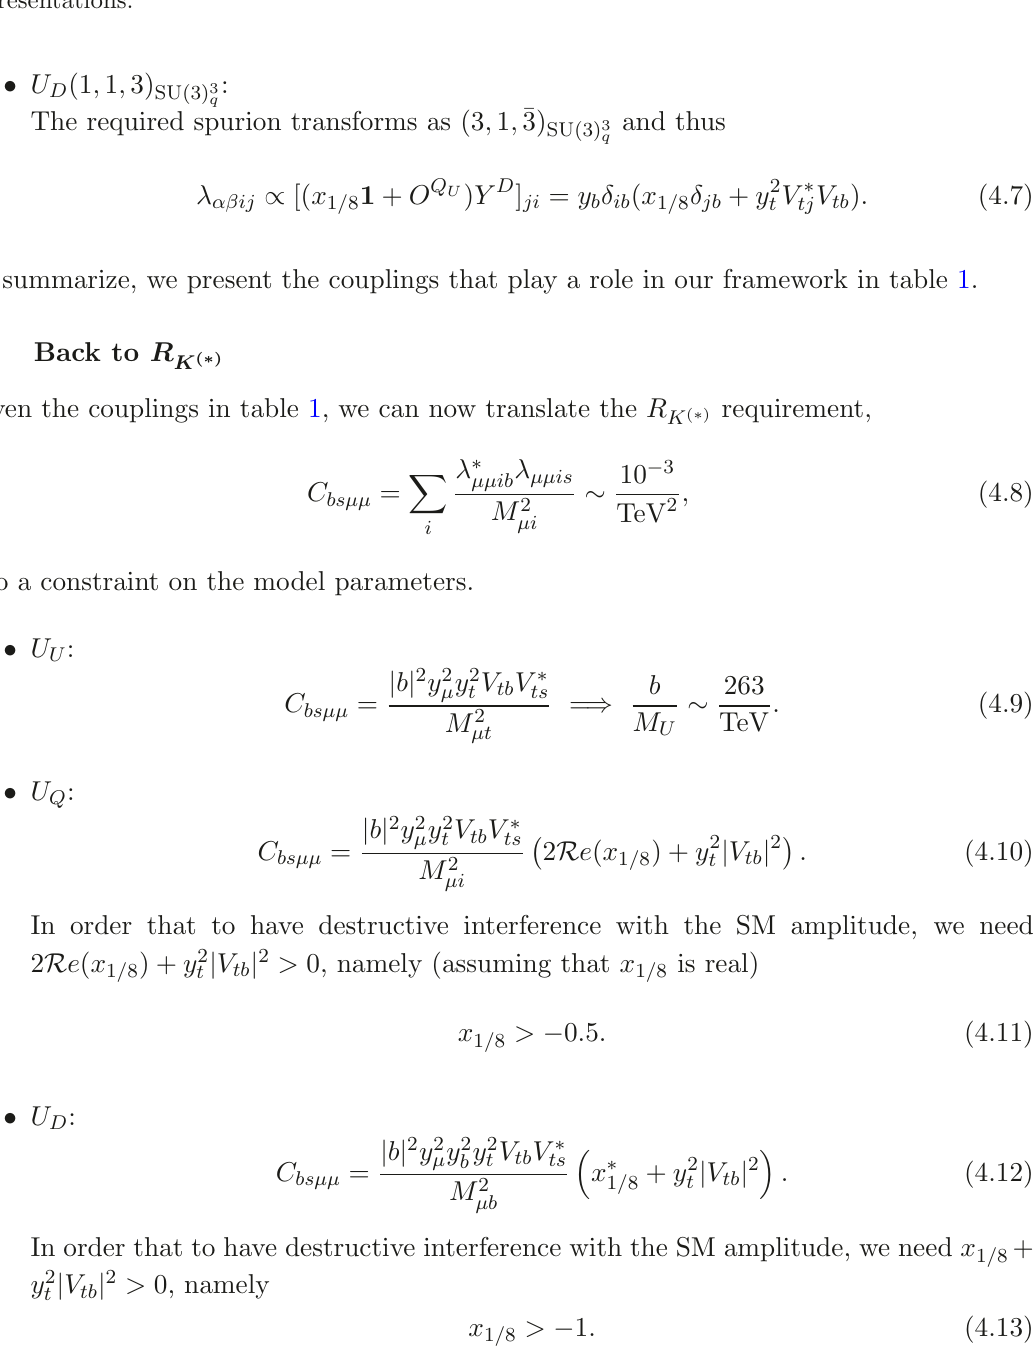
Table 1 . The λ αβij couplings in the down and charged lepton mass basis for the three flavor